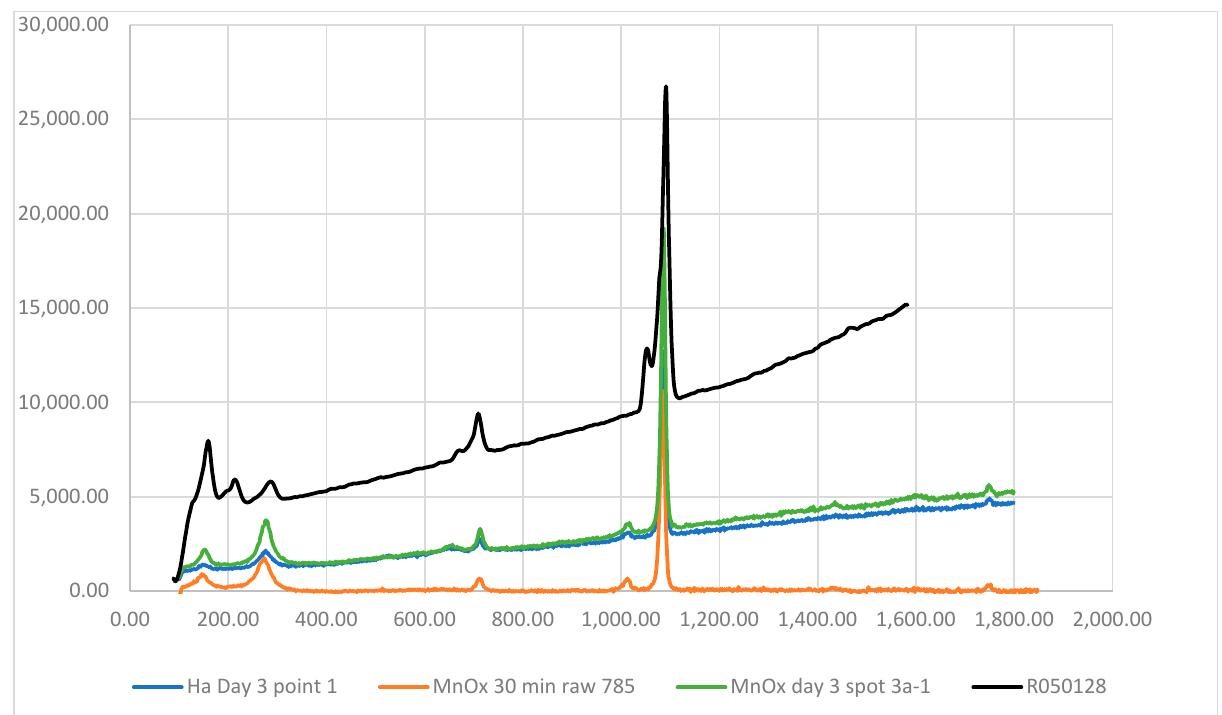
Figure 4. Crystals/precipitates showing on the surface of the media in water for 30 min and 3 days at 6 °C: ( a ) 30 min raw MnOx—CaSO 4 precipitates; ( b ) 30 min raw MnOx-sample 785 with CaCO 3 ;